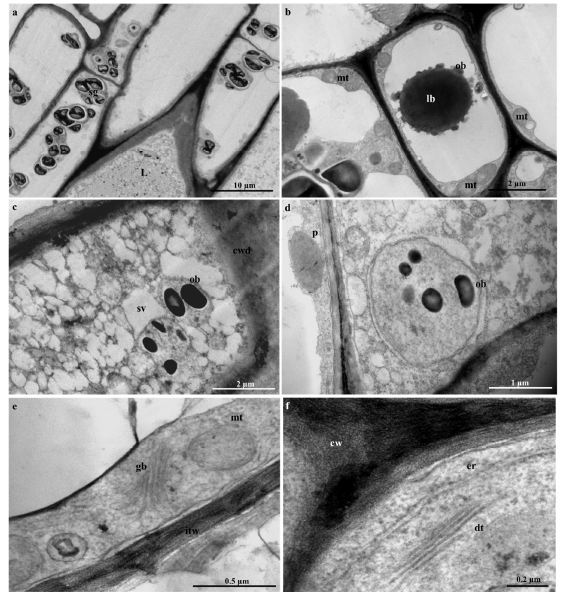
Figure 10. Ultrastructure of laticifers in the adult leaves of T. ventricosa . ( a ) Oblique section of a laticifer cell showing an acute apex and starch grains. ( b ) Lipid body closely associated with osmiophilic bodies. ( c ) Coalescence of small vacuole with granular laticifer cell content. ( d ) Osmiophilic bodies free in the cytosol and plastid with an electron-dense globule. ( e ) Presence of mitochondria, Golgi body and irregular thickening of cell walls. ( f ) Expansion of endoplasmic reticulum and presence of dictyosomes nearby the cell wall. Abbreviations: L = Laticifer, sg = starch grain, cwd = cell wall dissolution, sv = small vacuole, ob = osmiophilic bodies, p = plastid, gb = golgi body, mt = mitochondria, itw = irregular thickened walls, er = endoplasmic reticulum, dt = dictyosomes, cw = cell wall, lb = lipid body.